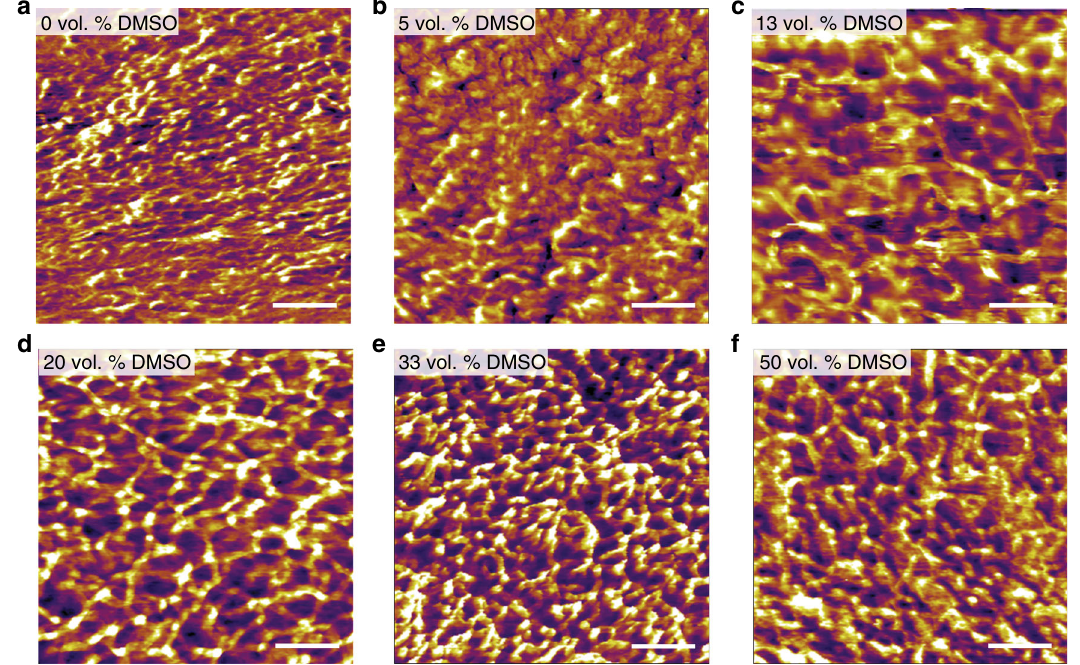
Fig. 3 AFM phase images of dry-annealed PEDOT:PSS free-standing fi lms. a Pristine PEDOT:PSS fi lm. b – f Dry-annealed pure PEDOT:PSS fi lms prepared by adding different amount of DMSO by b 5 vol.%, c 13 vol.%, d 20 vol.%, e 33 vol.%, and f 50 vol.%. Note that vol.% indicates the volume fraction of the added DMSO to the fi nal solution volume. The measured surface roughness is a 1.6 nm, b 1.4 nm, c 2.5 nm, d 2.0 nm, e 2.1 nm, and f 3.1 nm. Scale bars, 100